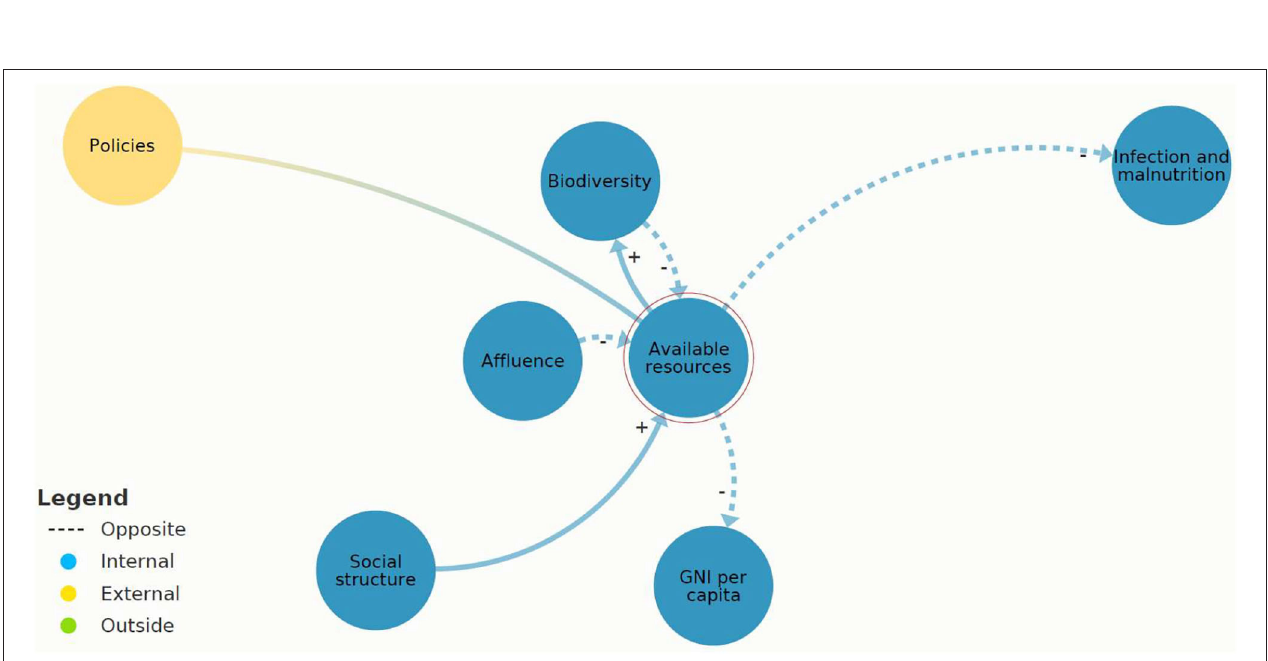
FIGURE 7 | A section of Figure 3 : causal loops in present antimicrobial resistance (AMR) system map of “available resources” created in Kumu.io (27).